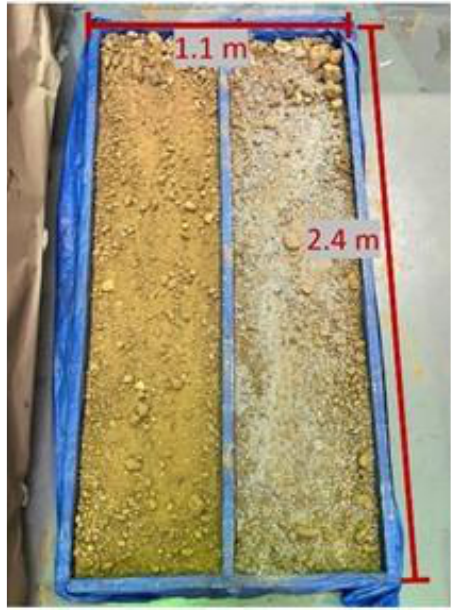
Figure 11. Soil beds created to test the transplanter